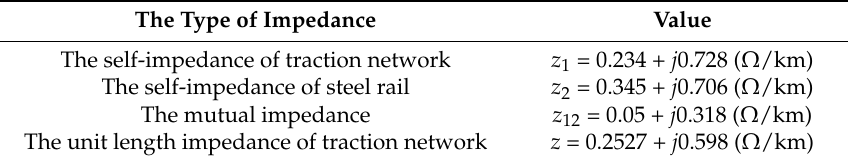
Table 1. The impedance calculation results of the traction